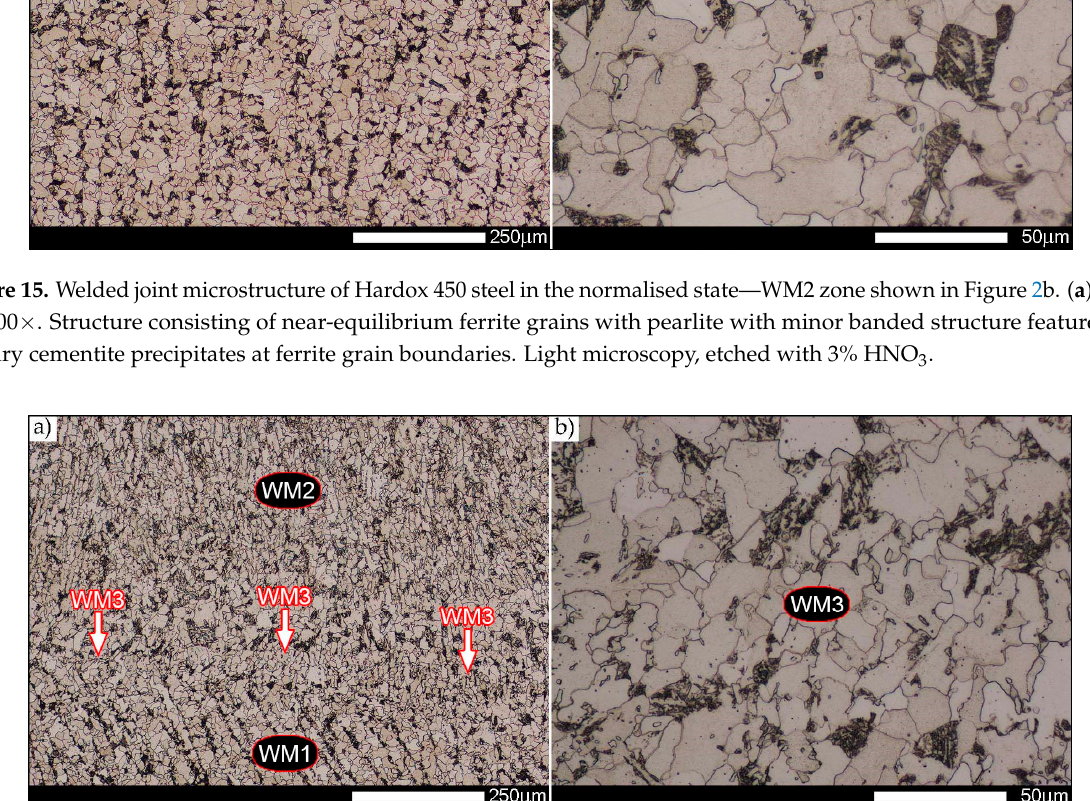
Figure 16. Welded joint microstructure of Hardox 450 steel in the normalised state—WM3 zone shown in Figure 2b. ( a ) 100×; ( b ) 500×. Structure of equilibrium and non-equilibrium grains of ferrite and lamellar and fine-lamellar pearlite. Tertiary cementite, often precipitated at the boundaries of ferrite grains in the form of a continuous network is also observed locally. Light microscopy, etched with 3% HNO 3 .